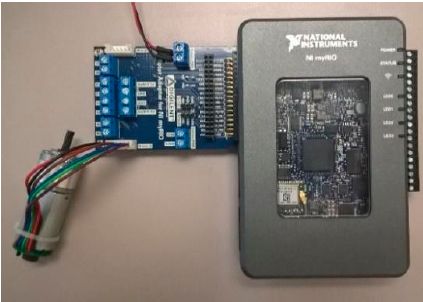
Figure 7. Block diagram of the experimental setup.